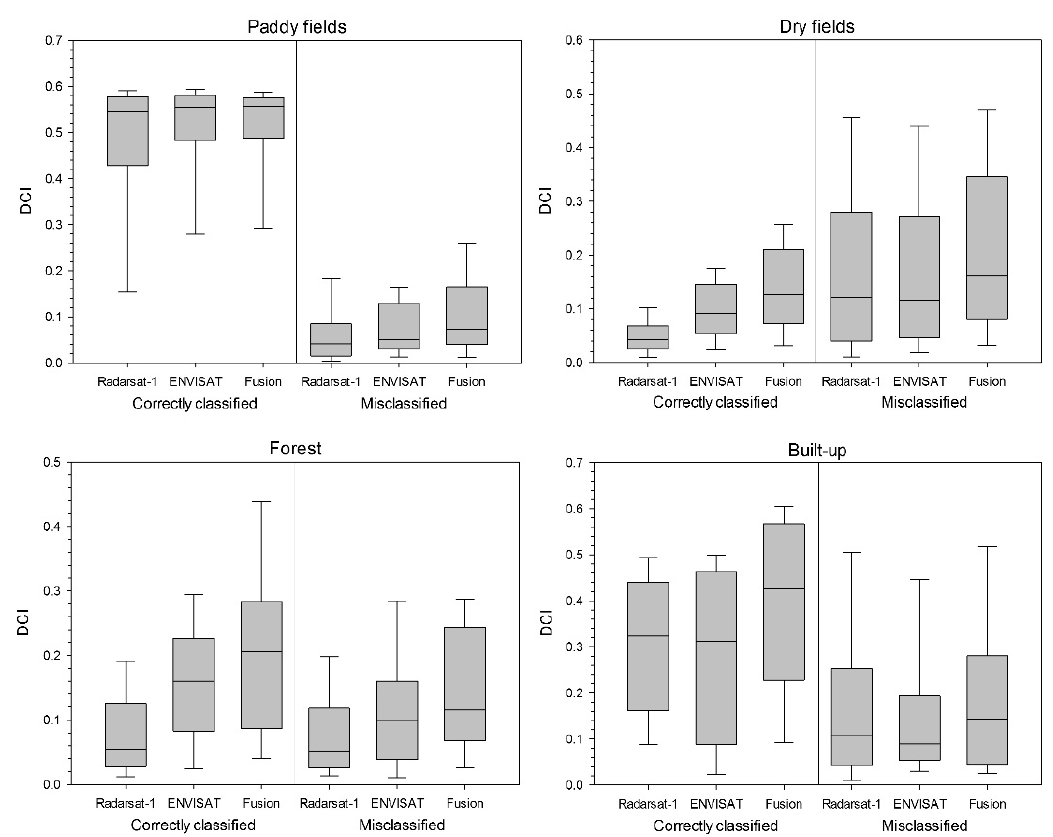
Figure 5. Box plot of DCI values per each class at the correctly and incorrectly classified reference pixels for different classification scenarios. For each box plot, whiskers above and below the box indicate the 90th and 10th percentiles, respectively. The top and bottom boundaries of the box indicate upper and lower quartiles, respectively. The line within the box corresponds to the median.